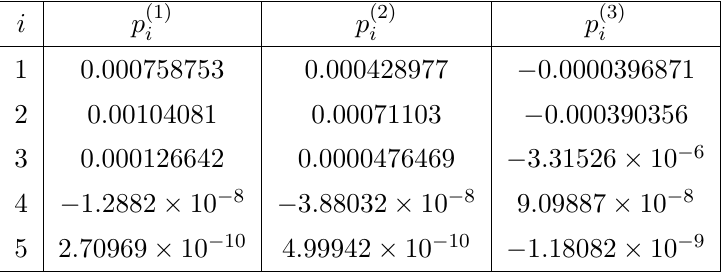
Table 3 . The coefficients p ( i )